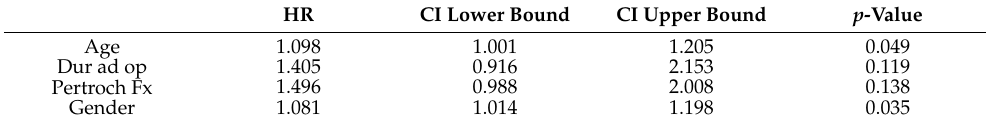
Table 4. Multivariate Cox regression for OS.